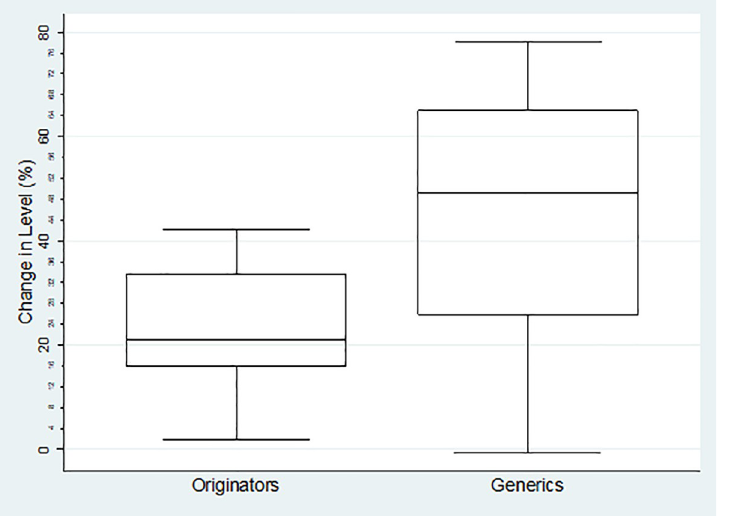
Fig 3. Percentage change in level in the Supplementary